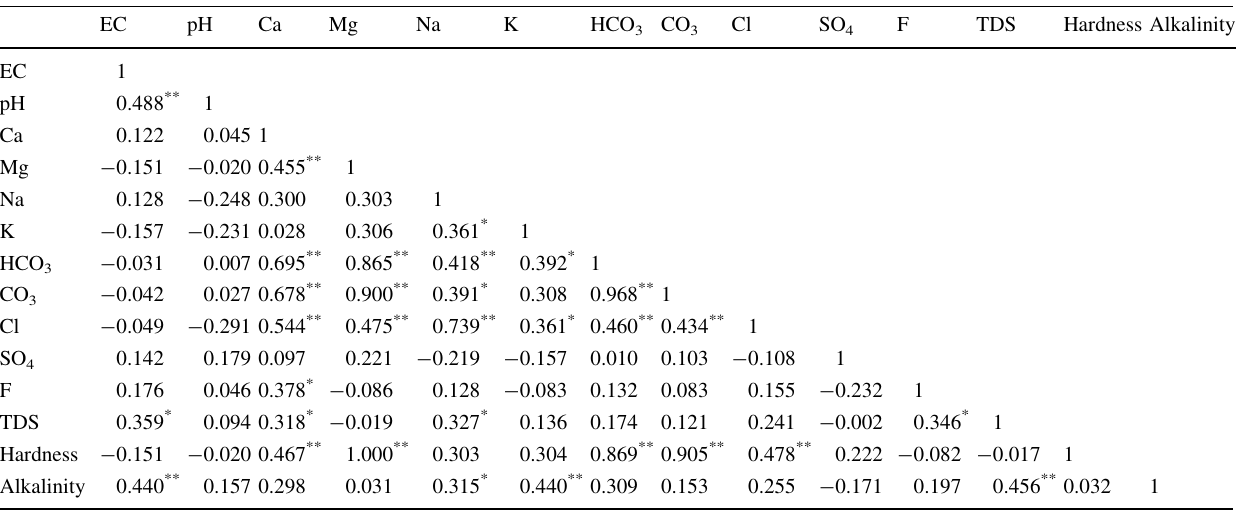
Table 2 Correlation matrix for groundwater samples of Tummalapalle area